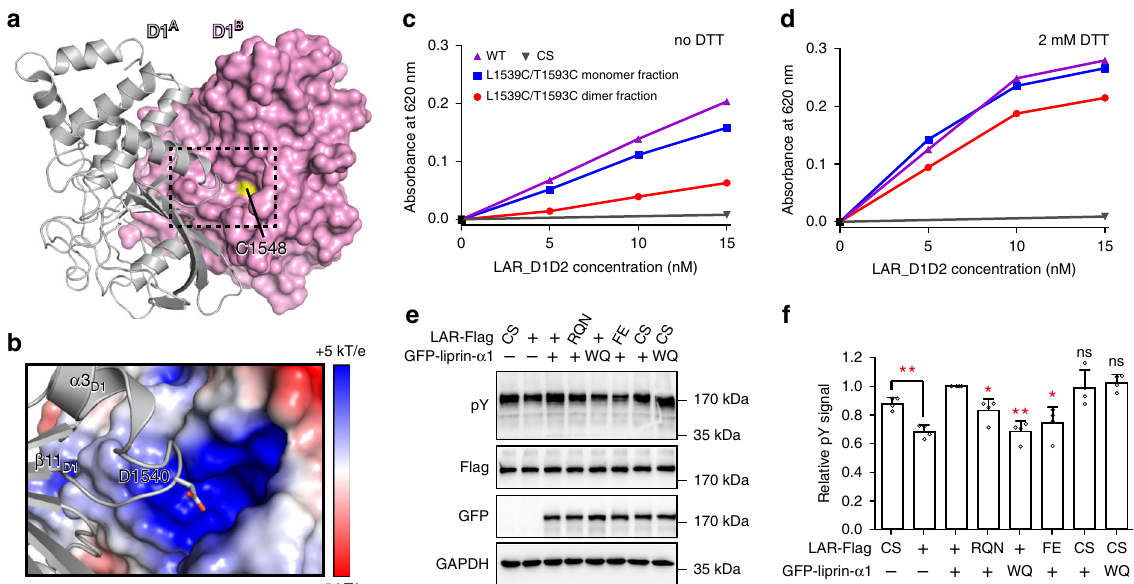
Fig. 5 The D1/D1 interaction interferes with the phosphatase activity of LAR. a Structural analysis of the steric blocking of the substrate entry by the D1/ D1 interaction. The two neighboring D1 domains, named D1 A and D1 B , were shown as white ribbons and magenta surface, respectively. The substrate- binding pocket was boxed. The catalytic residue, C1548 was highlighted in yellow. b Surface charge distribution of the substrate-binding pocket. D1540 in the α 3 D1 / β 11 D1 -loop was shown as stick mode. c, d Phosphatase activity analysis of LAR_D1D2 and its double-cysteine mutant in a reaction buffer without ( c ) or with DTT ( d ). The catalytically inactive C1548S (CS) mutant was used as the negative control. e Detection of total phosphorylated tyrosine (pY) in cells transfected with LAR and its CS mutant alone, or co-transfected with various variants of LAR and liprin- α 1. Immunoblots were probed with indicated primary antibodies. f Quanti fi cation of pY intensities as shown in ( c ). Data were obtained from four independent experiments. Intensities were normalized by setting the pY intensity measured from cells expressing wild-type LAR-Flag and GFP-liprin- α 1 as 1. Error bars represent s.d. The paired Student ’ s t test analysis was used to de fi ne a statistically signi fi cant difference (* p < 0.05; ** p < 0.01; *** p < 0.001; ns not signi fi